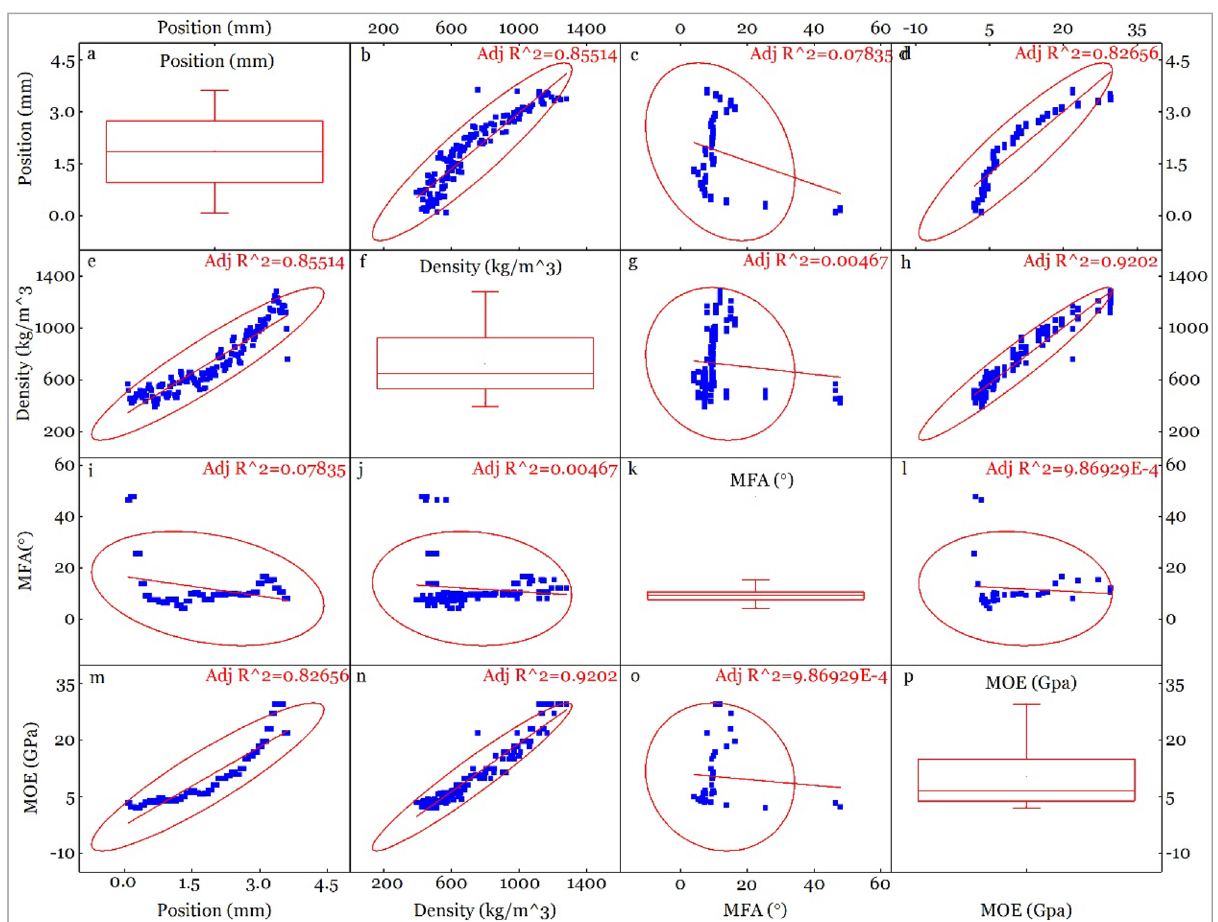
Figure 6. Correlation between position, density, MFA and MOE of compression